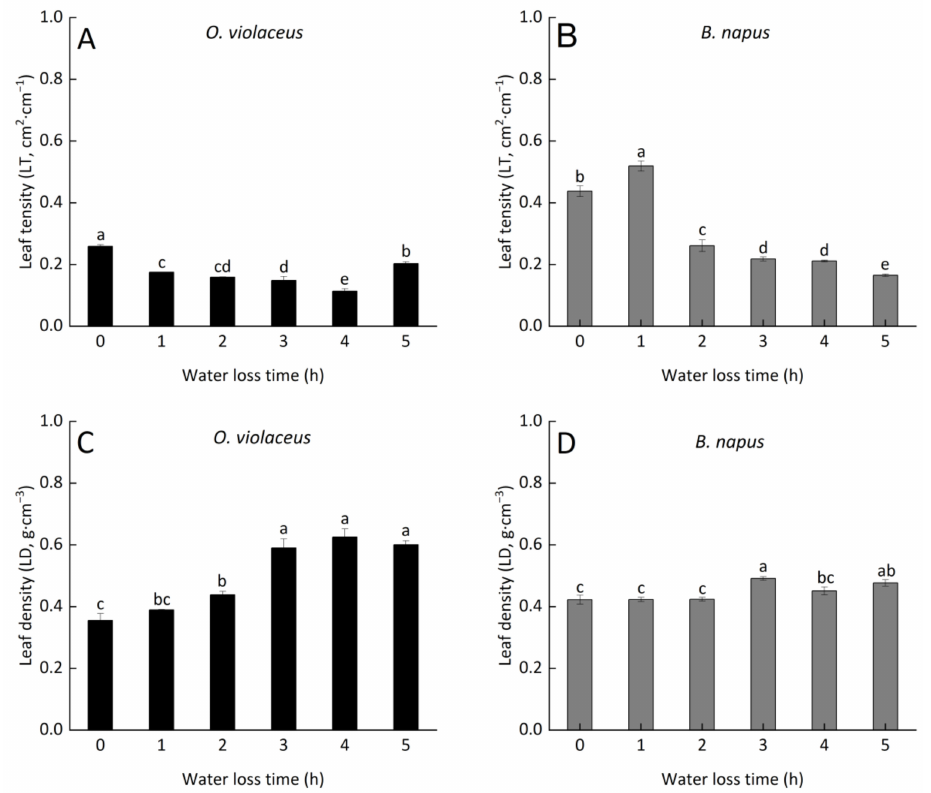
Figure 2. Leaf tensity (LT, cm 2 · cm − 1 ) and leaf density (LD, g · cm − 3 ) of O. violaceus and B. napus at different dehydration times. (Note: ( A ) LT of O. violaceus ; ( B ) LT of B. napus ; ( C ) LD of O. violaceus ; ( D ) LD of B. napus . Different letters appear above the error bars of the same parameter in the same plant species when subsequent values differ significantly at p ≤ 0.05, according to one-way